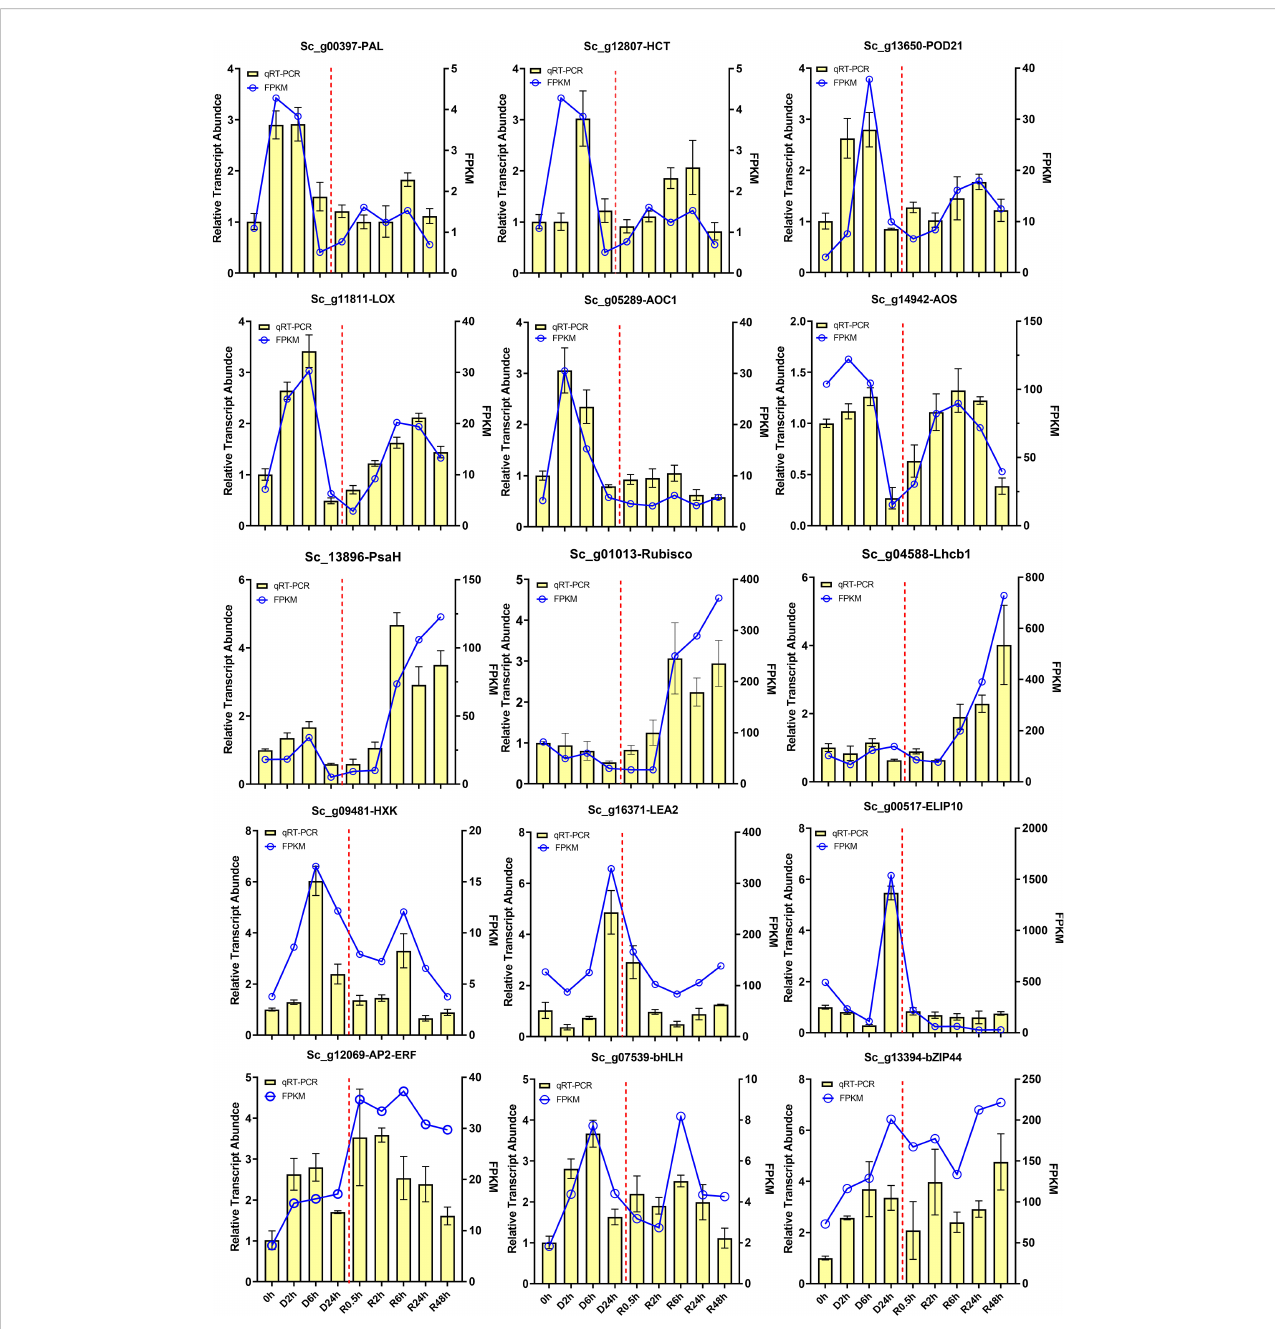
FIGURE 7 RT-qPCR validation of interested transcripts in S. caninervis during D-R process. Selected transcript abundance pro fi les were validated using RT-qPCR, including phenylpropanoid biosynthesis: ScPAL (Sc_g00397), ScHCT (Sc_g12807) and ScPOD21 (Sc_g13650); a -linolenic acid pathway: ScLOX (Sc_g11811), ScAOC1 (Sc_g05289) and ScAOS (Sc_g14942); photosynthesis and fructose and mannose metabolism: ScPsaH (Sc_g13896), ScRubisco (Sc_g01013), ScLHcb1 (Sc_g04588), and ScHXK (Sc_g09481); DT-related trancripts: ScLEA2 (Sc_g16371) and ScELIP10 (Sc_g00517). TFs: ScAP2-ERF (Sc_g12069), ScbHLH (Sc_g07539), and bZIP (Sc_g13394). RT-qPCR data were showed as the mean ± SD. Line chart represents FPKM value, and bar chart represents RT-qPCR